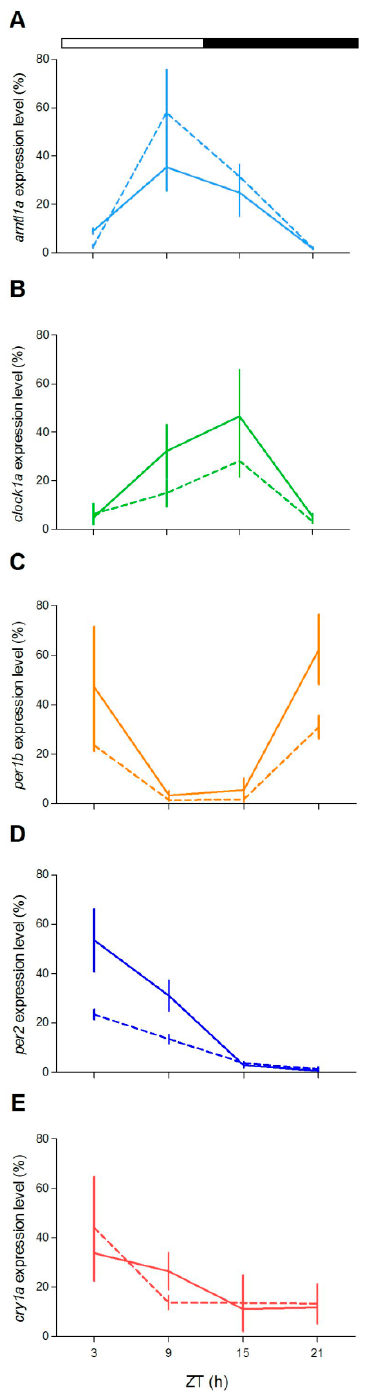
Figure 7. Daily expression levels of clock genes in zebrafish adult eye. qPCR analysis of clock ( A – C ) and light-regulated clock ( D – E ) gene expression in the eye of zebrafish exposed to LD cycles. For all panels, each point represents the mean ± SEM (n = 4). gr +/+ = solid line; gr − / − = dotted line. For more details see Figure 4.